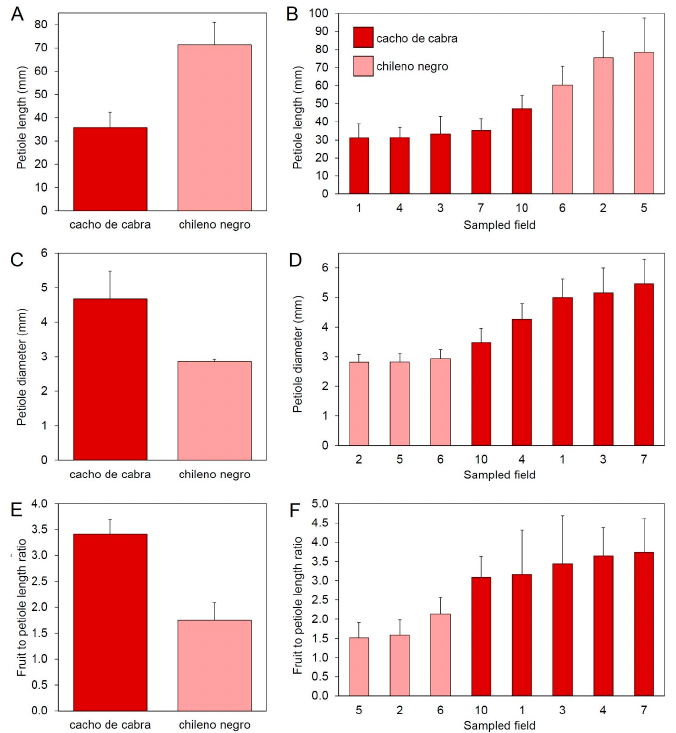
Figure 6. Morphological fruit variables differentiating Chilean landraces of chili pepper. Average values for each landrace ( A , C , E ) and values for individual fields sampled ( B , D , F ). Bars indicate standard deviation.